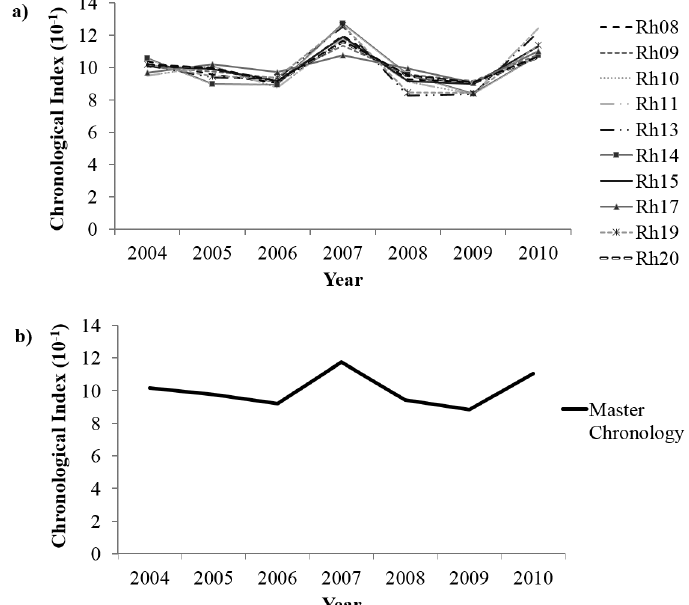
Figure 3 - Indexed chronologies of each tree ( a ) and the indexed master chronology ( b ).